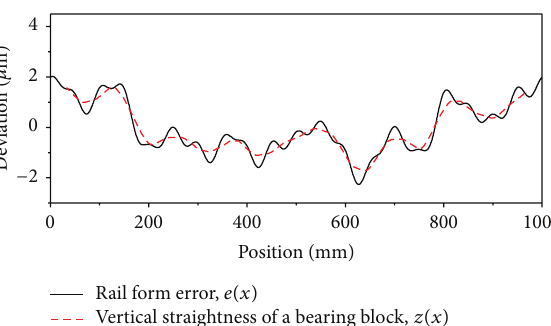
Figure 5: The assumed rail error and Fourier coefficients.